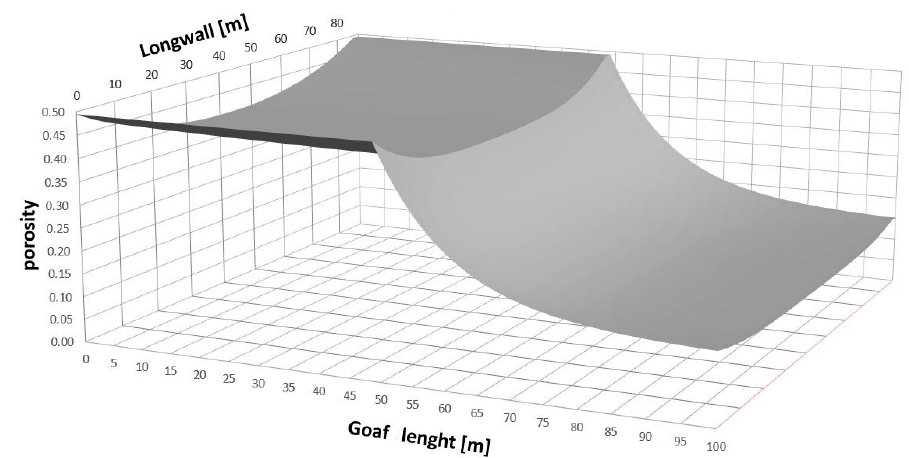
Figure 5. Porosity distribution—perspective view.